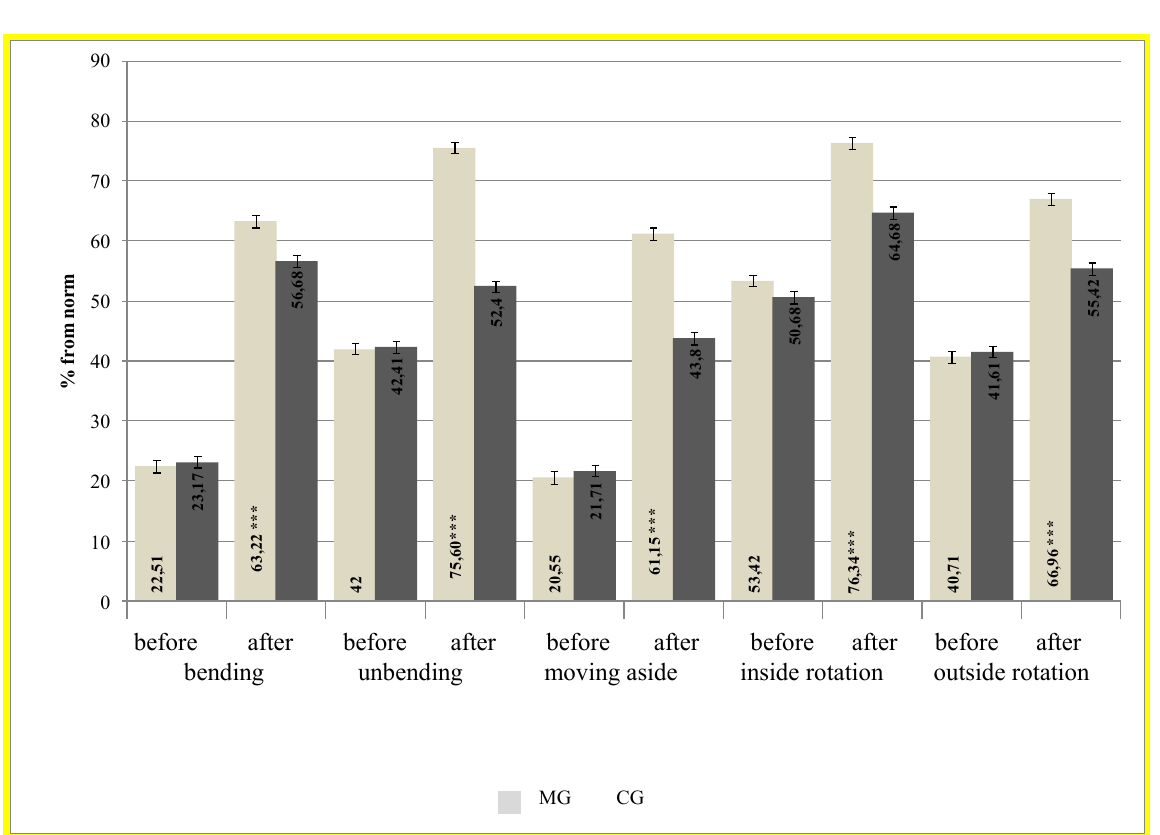
Fig.1. Change of goniometry indicators in MG, comparing with CG in % from norm under influence of rehabilitation, where: *** – р<0,001(comparison of MG initial and final indicators); ••• – р<0,001 (comparison of CG initial and